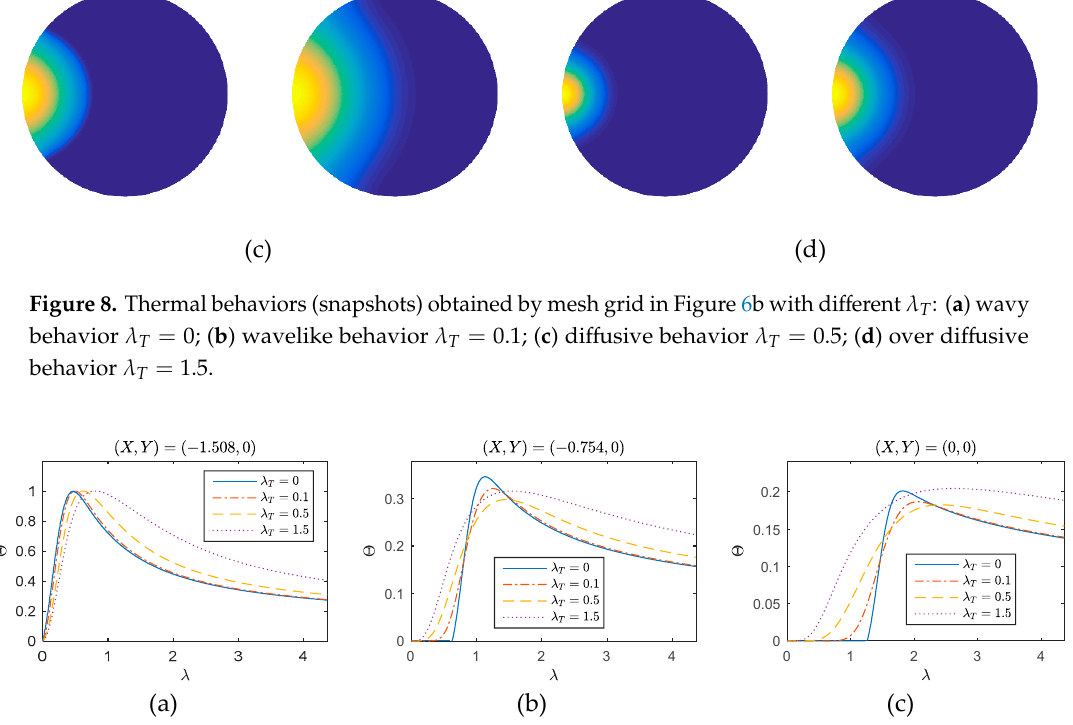
λ Figure 9. WFEM performances for di ff erent λ T : ( a ) ( X , Y ) = ( − 1.508, 0); ( b ) ( X , Y ) = ( − 0.754, 0); ( c ) ( X , Figure 9. WFEM performances for different T : ( a ) ( X , Y ) = (-1.508, 0); ( b ) ( X , Y ) = (-0.754, 0); ( c ) ( X ,